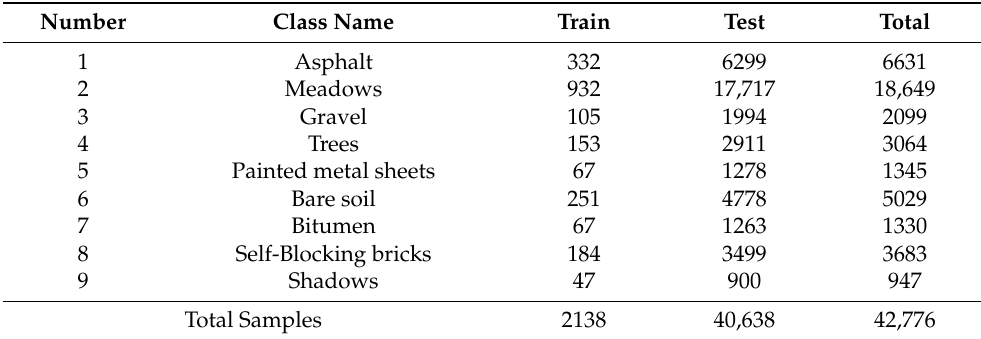
Table 2. Number of training and testing samples for the Pavia University